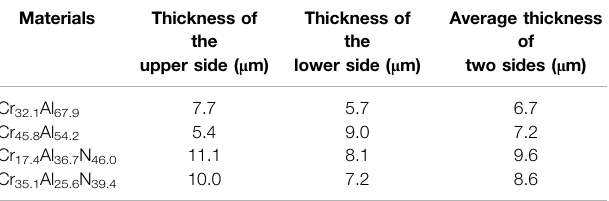
TABLE 2 | | Thickness of various ATF coatings with 2 h deposition. Materials Thickness of the